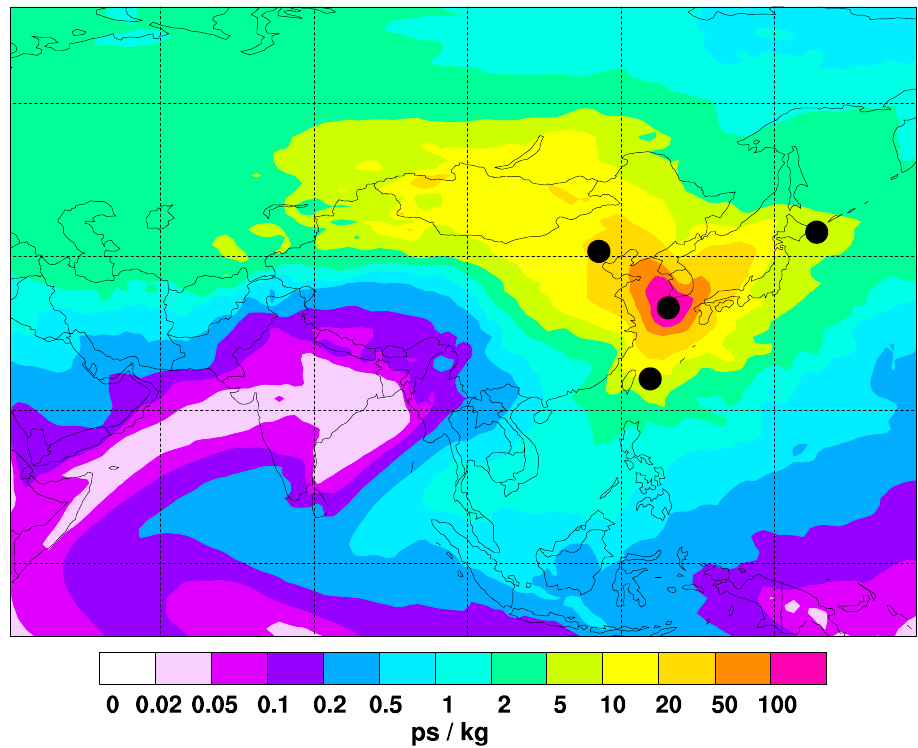
Fig. 1. Footprint emission sensitivity in picoseconds per kilogram obtained from FLEXPART 20 d backward calculations averaged over all model calculations for all stations and for the entire year 2008. Measurement sites are marked with black